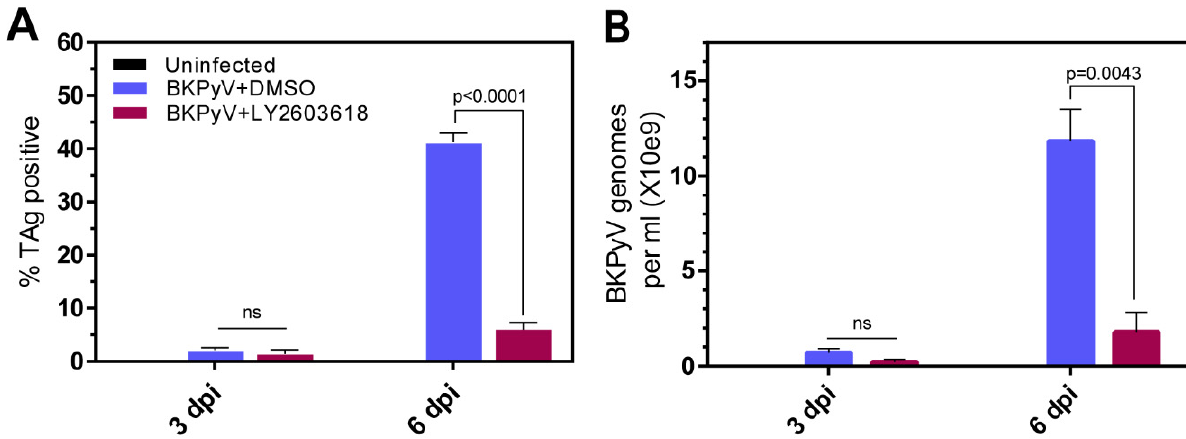
Figure 7. LY2603618 limits spreading BKPyV infection in vitro. Parallel cultures of quiescent RPTECs were infected with BKPyV Dunlop (MOI = 0.1 IU/cell) and treated with either 4 µ M LY2603618 or 0.02% DMSO beginning at 1.5 hpi. Cells and culture media were harvested at 3 dpi and 6 dpi. For cultures harvested at 6 dpi, media including LY2603618 or DMSO was replaced at 3 dpi. ( A ) Percent TAg-positive cells. Cells on cover slips were fixed, stained with anti-TAg (PAb416), followed by goat anti-mouse Alexa 594. Cover slips were stained with DAPI prior to immunofluorescent microscopy and quantification of percent TAg-positive cells by Cell Profiler Count and Score software. ( B ) BKPyV DNA release into culture media. DNA was purified from culture media and analyzed by real-time PCR using BKPyV-specific primers. Error bars indicate standard errors. Statistical significance was determined with a paired, two-tailed t-test (GraphPad Prism).